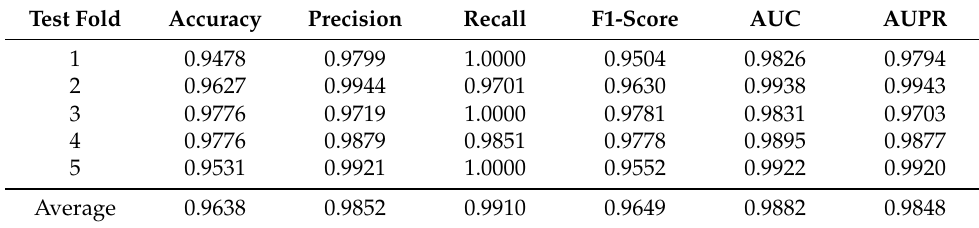
Table 2. Results of fivefold CV based on cicRNADisease dataset of best